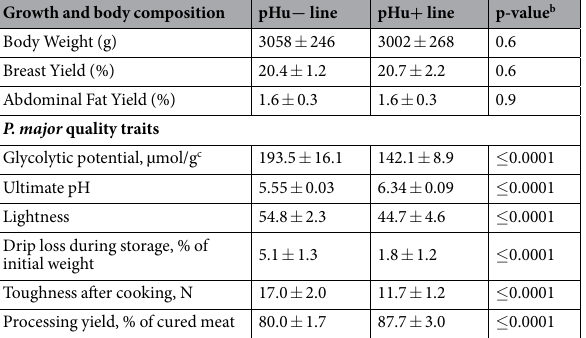
Table 1. Body composition and pectoralis major muscle traits a of the pHu − (n = 15) and pHu + (n = 16) individuals. a Values are expressed as the mean ± SD; b Two-tailed Welch’s mean values equality t-test at 95% confidence level; c Measured at 15 min